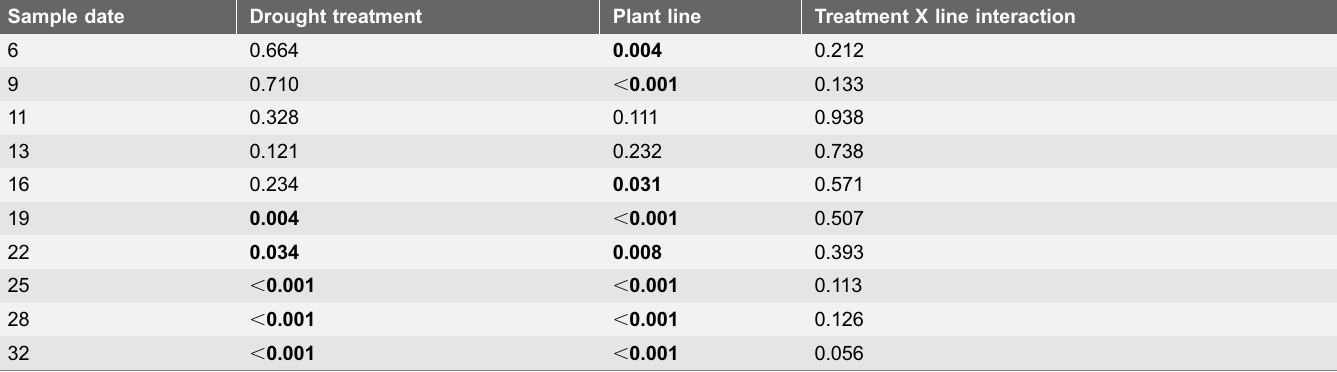
Table 1. Results for 2-way ANOVA performed on total plant length at each sample